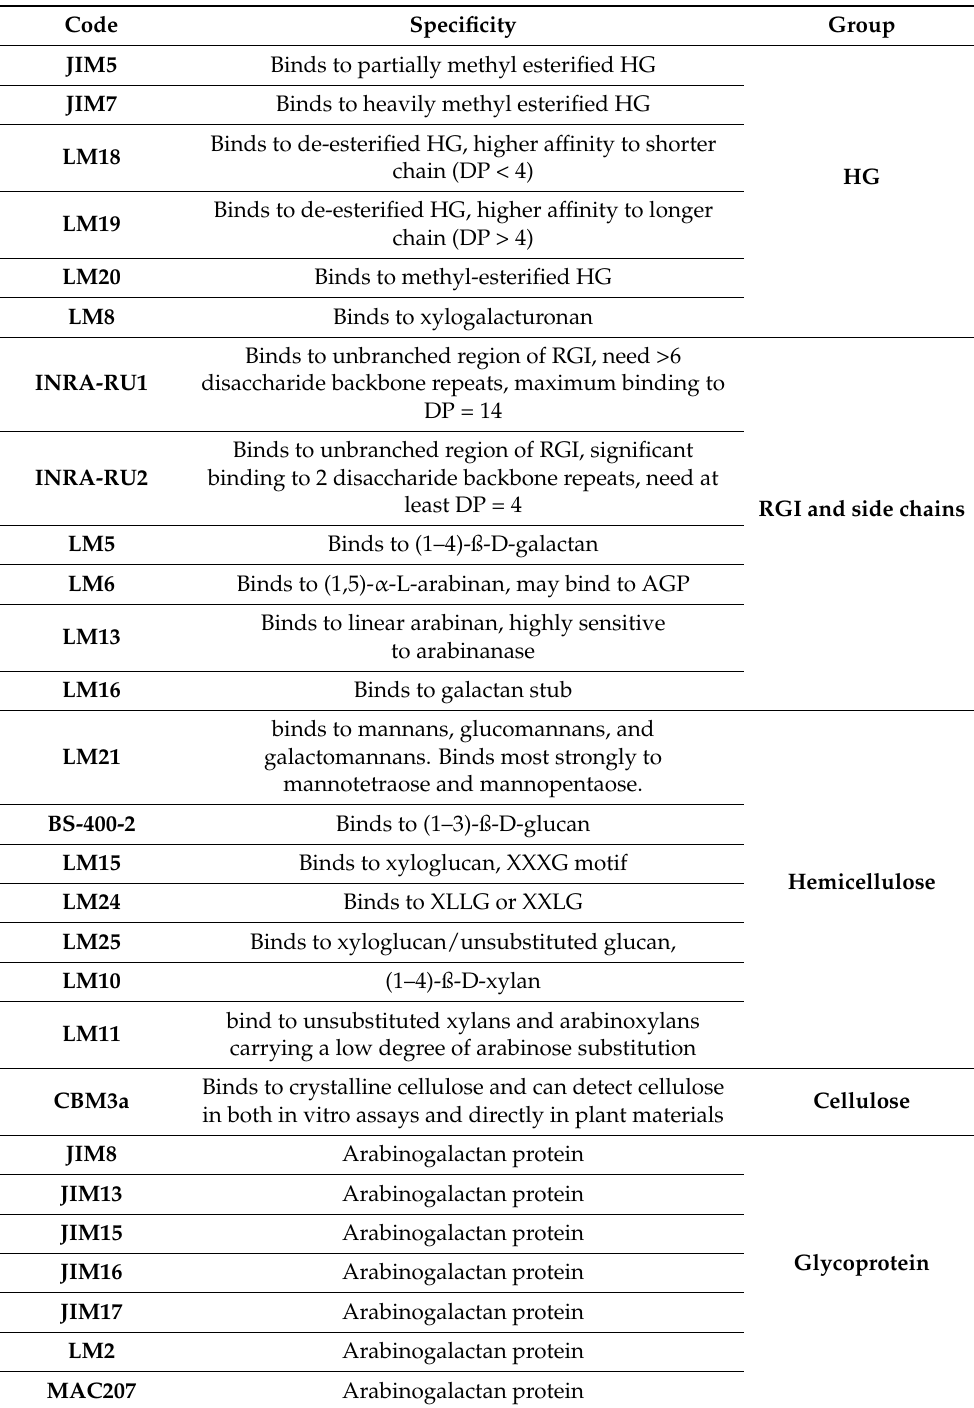
Table 1. mAbs and CBMs used in the CoMPP analysis. HG: homogalacturonan; RG I: Rhamnogalac- turonan